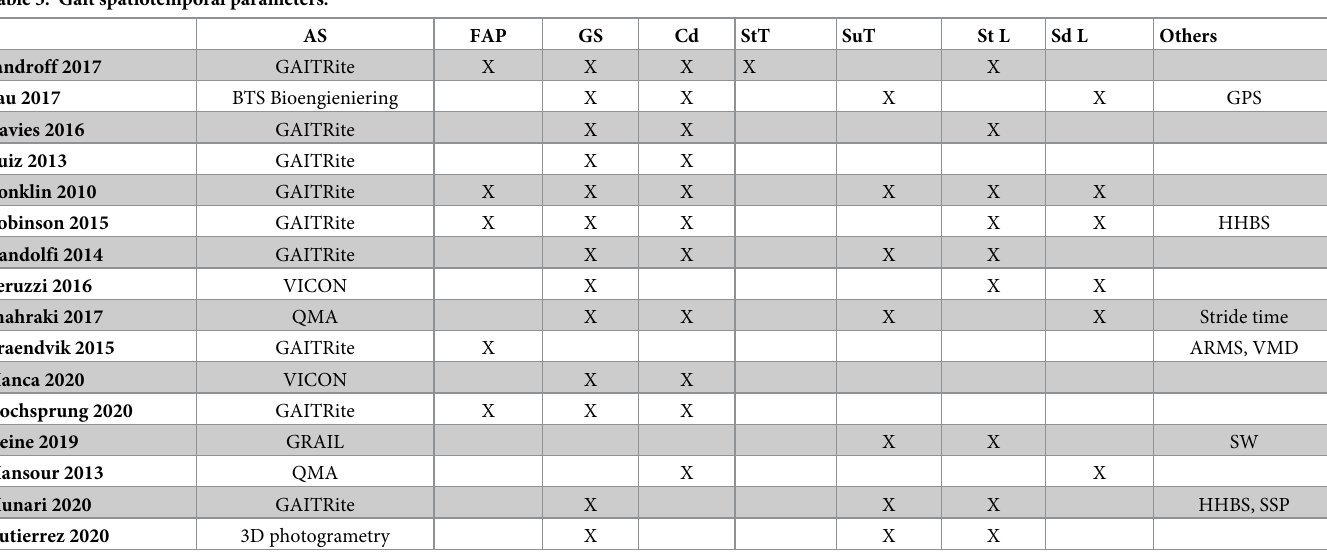
Table 3. Gait spatiotemporal